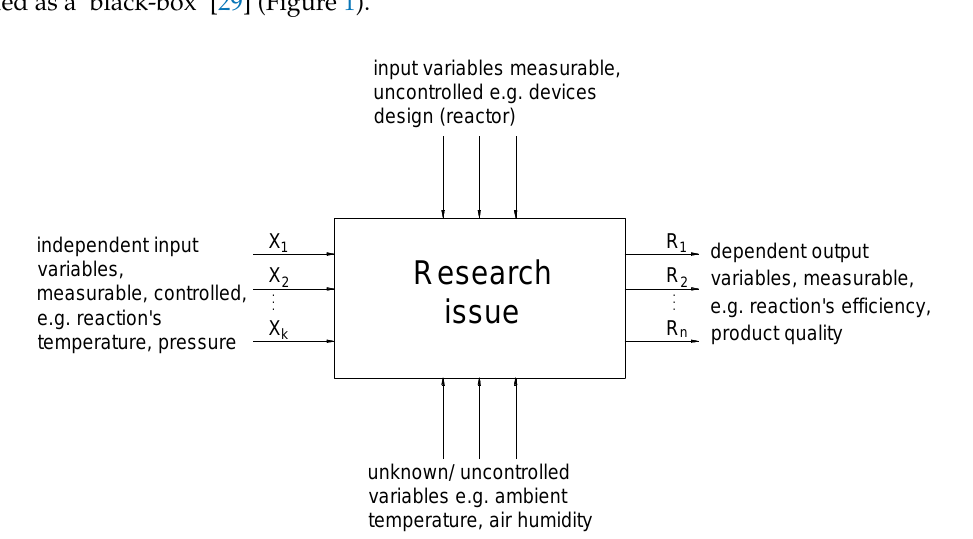
Table 1. The Box-Behnken design matrix and experimental data.